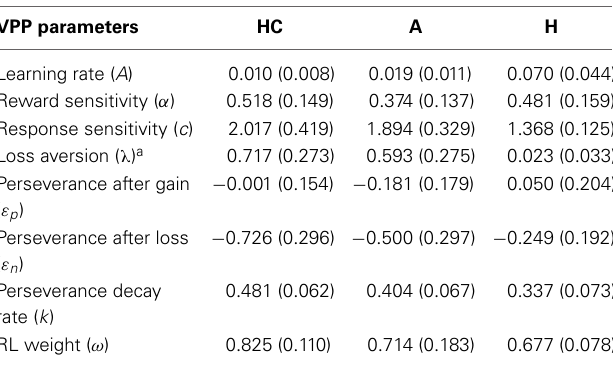
Table 4 | Means and standard deviations (in parentheses) of group mean parameters with the VPP